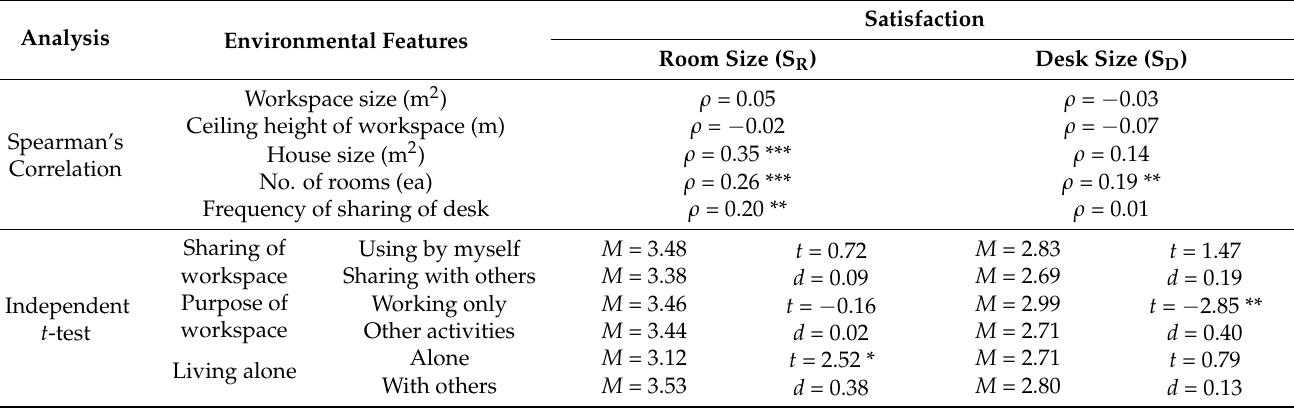
Table 3. Relationships between size-related environmental features and satisfaction with home workspace